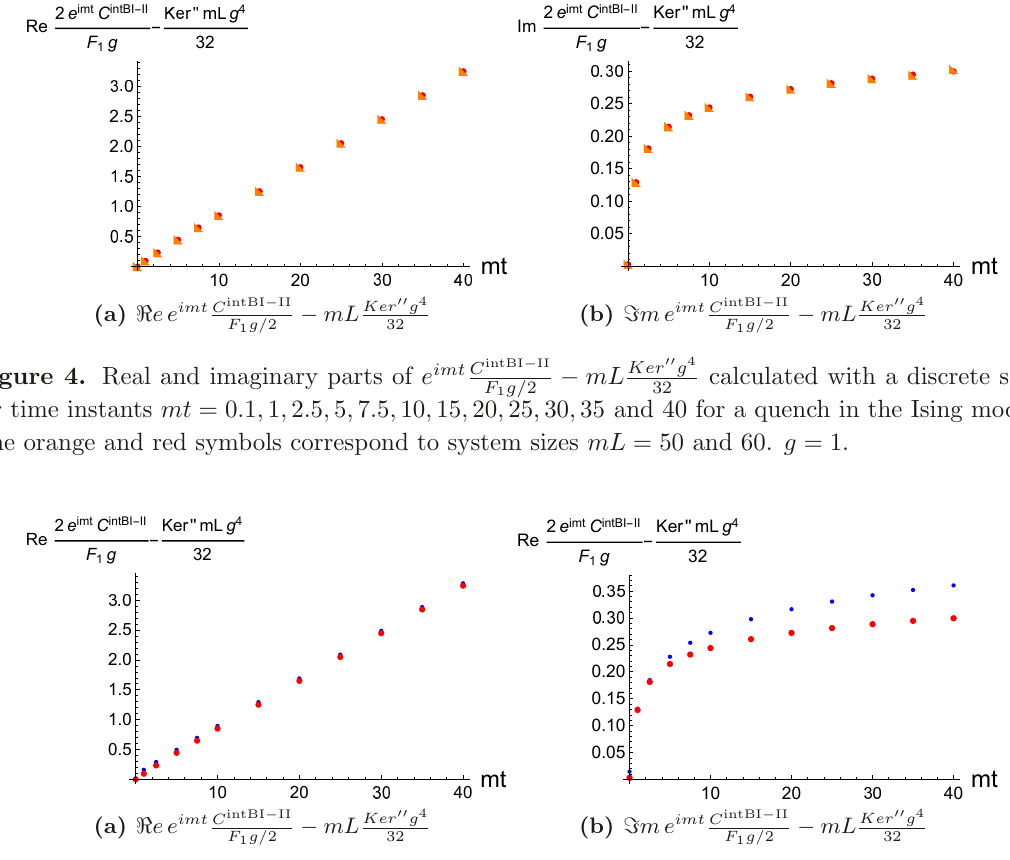
′′ g 4 mL Ker calculated by a discrete sum and 32 F 1 g/ 2 −